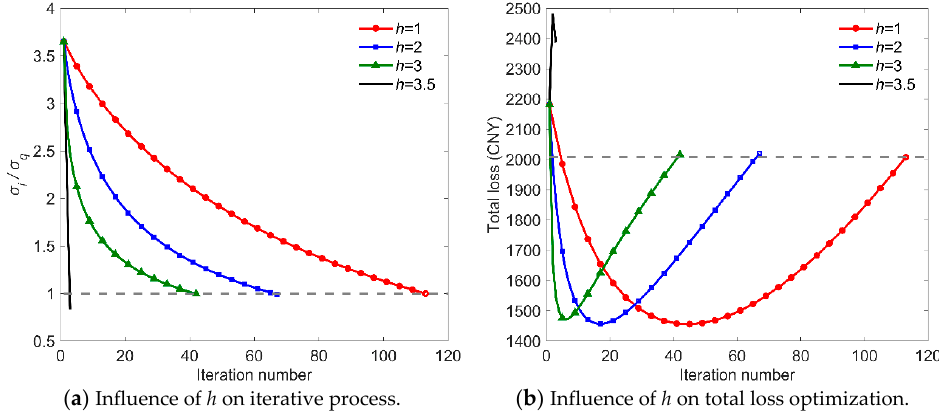
Figure 8. Influences of h on the optimization process.